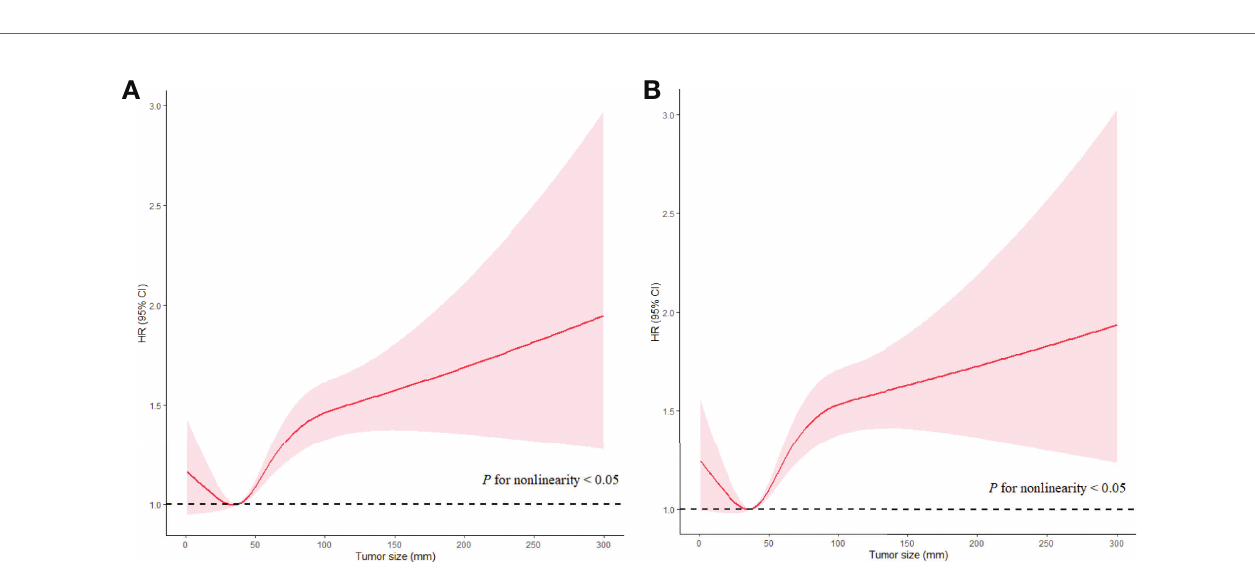
FIGURE 3 | Associations of Ts with prognosis in EC patients with LNM in RCS with Cox models after adjustment. Red lines estimated hazard ratio of tumor size; shadow area 95% CI. (A) Adjusted RCS model for ACD. (B) Adjusted RCS model for ESD.